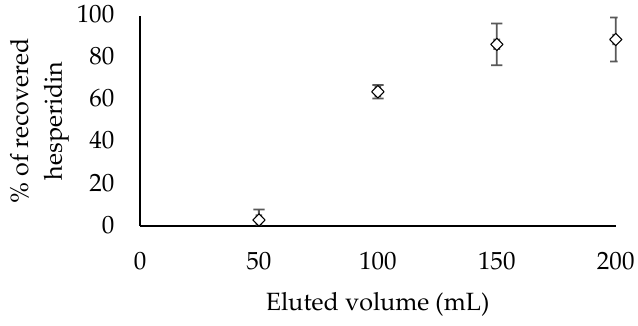
Figure 6. Hesperidin recovery efficiency during desorption.